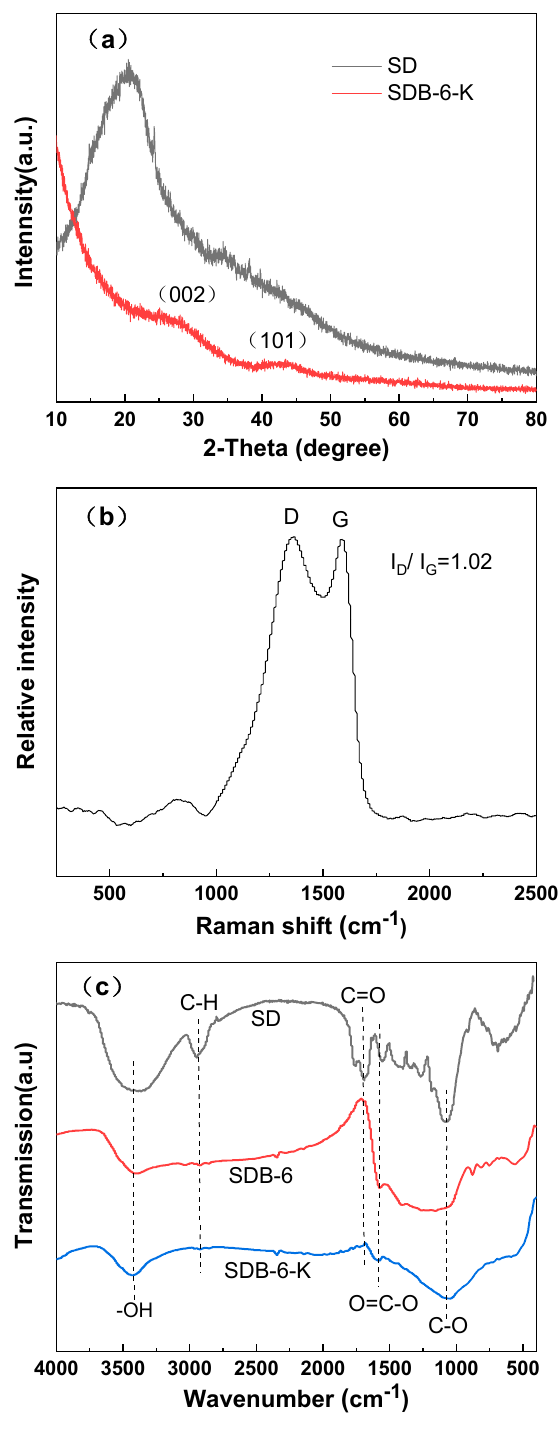
Figure 4. ( a ) XRD spectra of SD and SDB-6-K; ( b ) Raman spectra of SDB-6-K; ( c ) FTIR spectra of SD, SDB-6, and SDB-6-K.